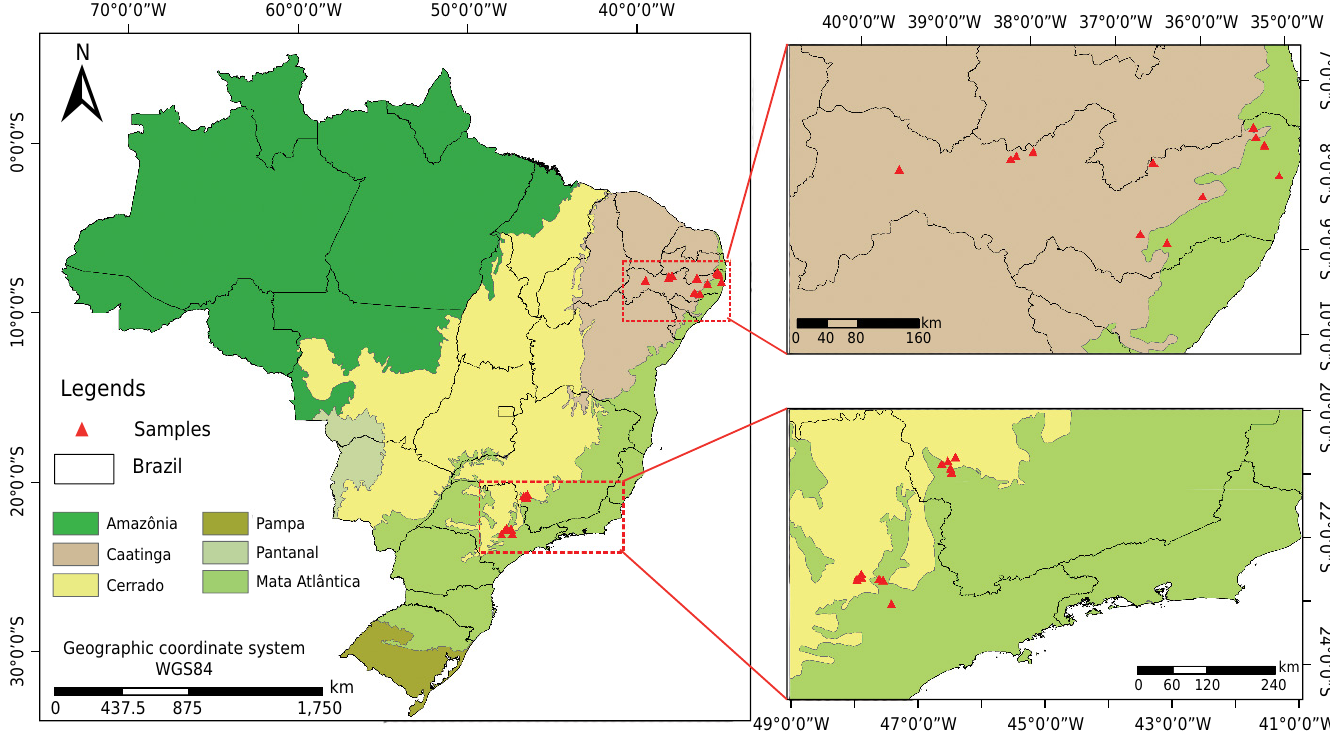
Figure 1. Profile of the Brazilian biomes (IBGE, 2004).